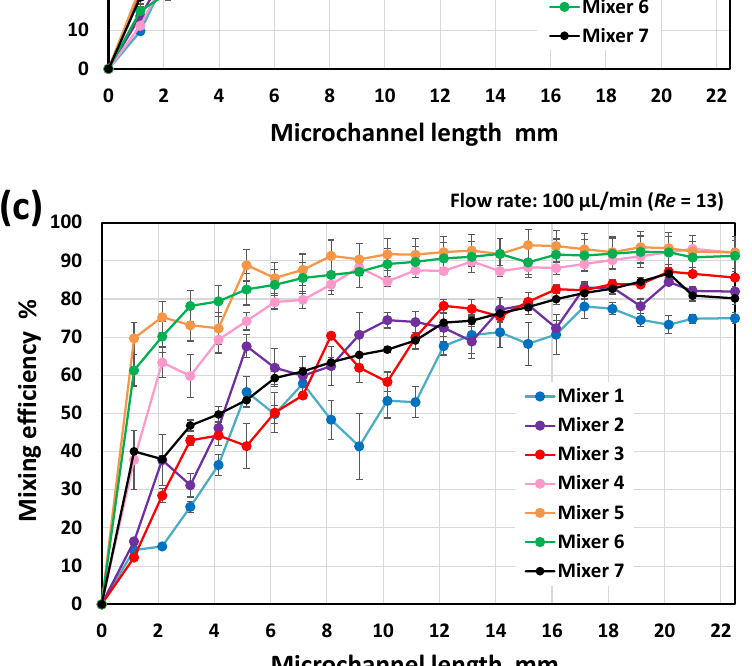
Figure 10. Experimental results showing the mixing efficiencies of six different types of asymmetric micromixers (M1–M6) and the serpentine micromixer (M7) at a total flow rate of ( a ) 1 µL/min and Re = 0.13, ( b ) 10 µL/min and Re = 1.3, and ( c ) 100 µL/min and Re = 13.